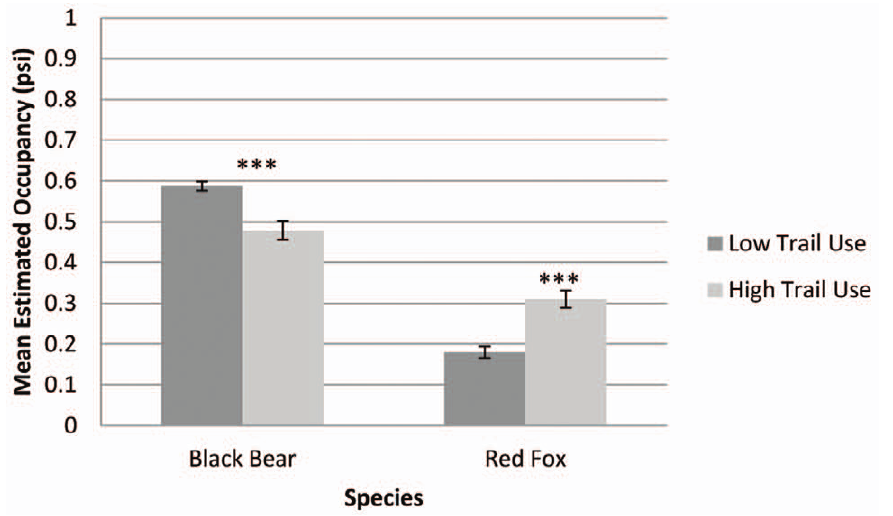
Figure 3. Mean and standard error of estimated occupancy in low vs. high trail use areas for the 2 species for which trail use was present in the top models and received . 0.5 Akaike weight. Asterisks represent level of significance based on two sample t-test assuming unequal variance (***=p , 0.001).